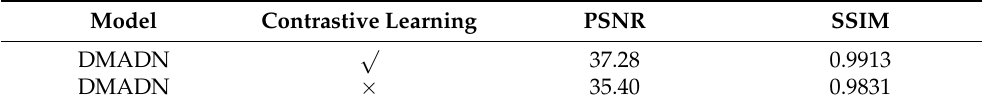
Table 4. Ablation study on contrastive